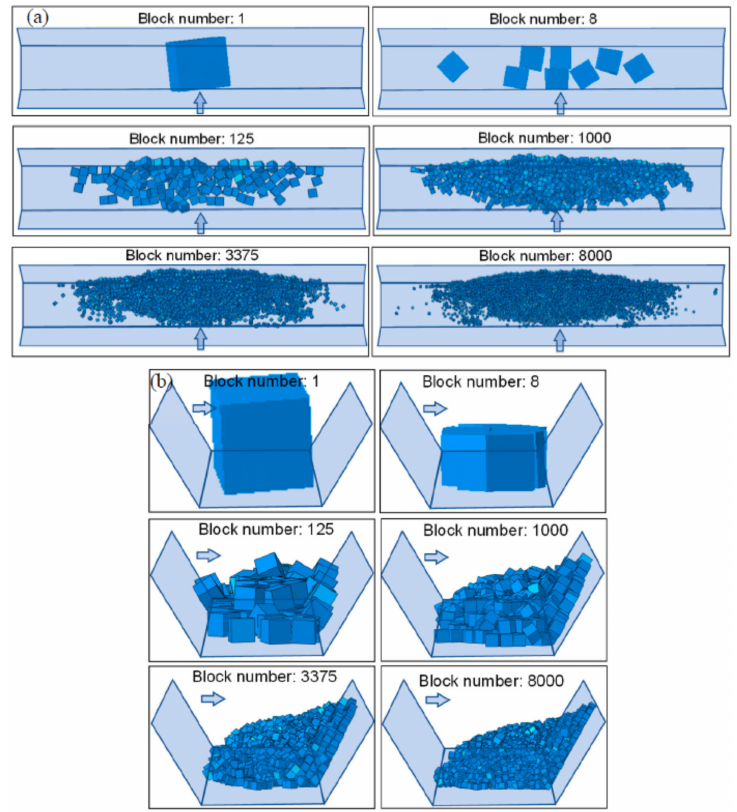
Figure 17. The shape of the landslide dam under different fracturing degree conditions: ( a ) plane view of landslide dam; ( b ) longitudinal profile of landslide